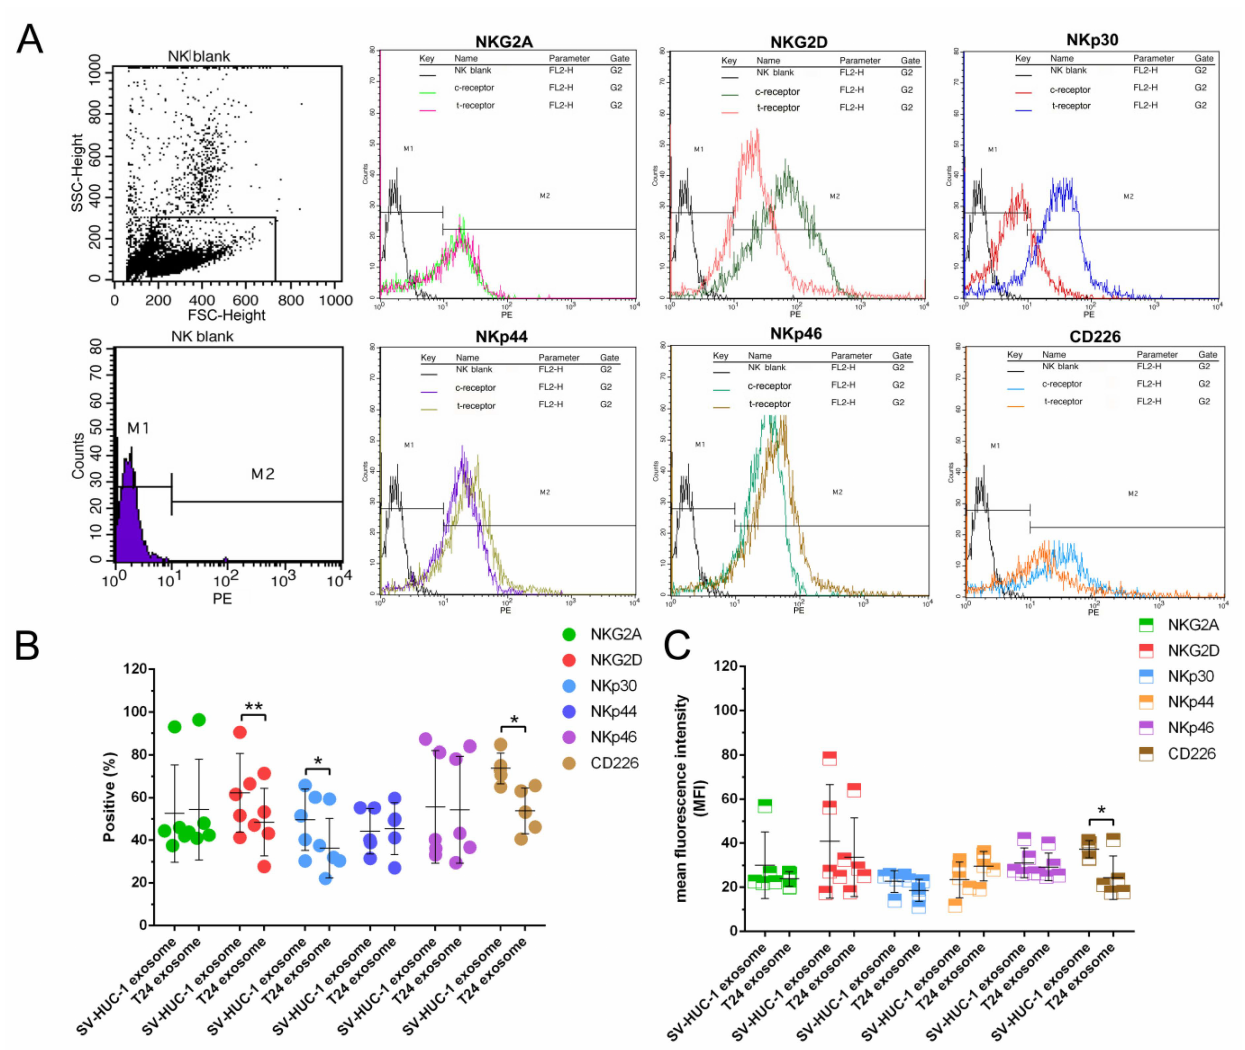
Figure 5. The effects of T24 exosome on the expression of NK cells functional receptors. ( A ): The representative flow cytometry data of the expression of NK cells functional receptors (NKG2A, NKG2D, NKp30, NKp44, NKp46 and CD226). ( B ): The bar graph showed the positive rate of NK cells functional receptors (n = 5); ( C ): The bar graph showed the mean fluorescence intensity (MFI) of NK cells functional receptors (n = 5); The positive rate of NKG2D, NKp30 and CD226 were reduced after T24 exosome treatment; The MFI of CD226 was reduced after T24 exosome treatment as well. * t test, p < 0.05; ** t test, p <